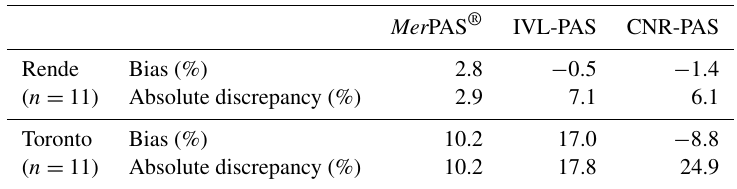
Table 2. Average bias and average absolute discrepancy between the time-averaged volumetric air concentrations of Hg derived by the passive air samplers and the Tekran instrument.